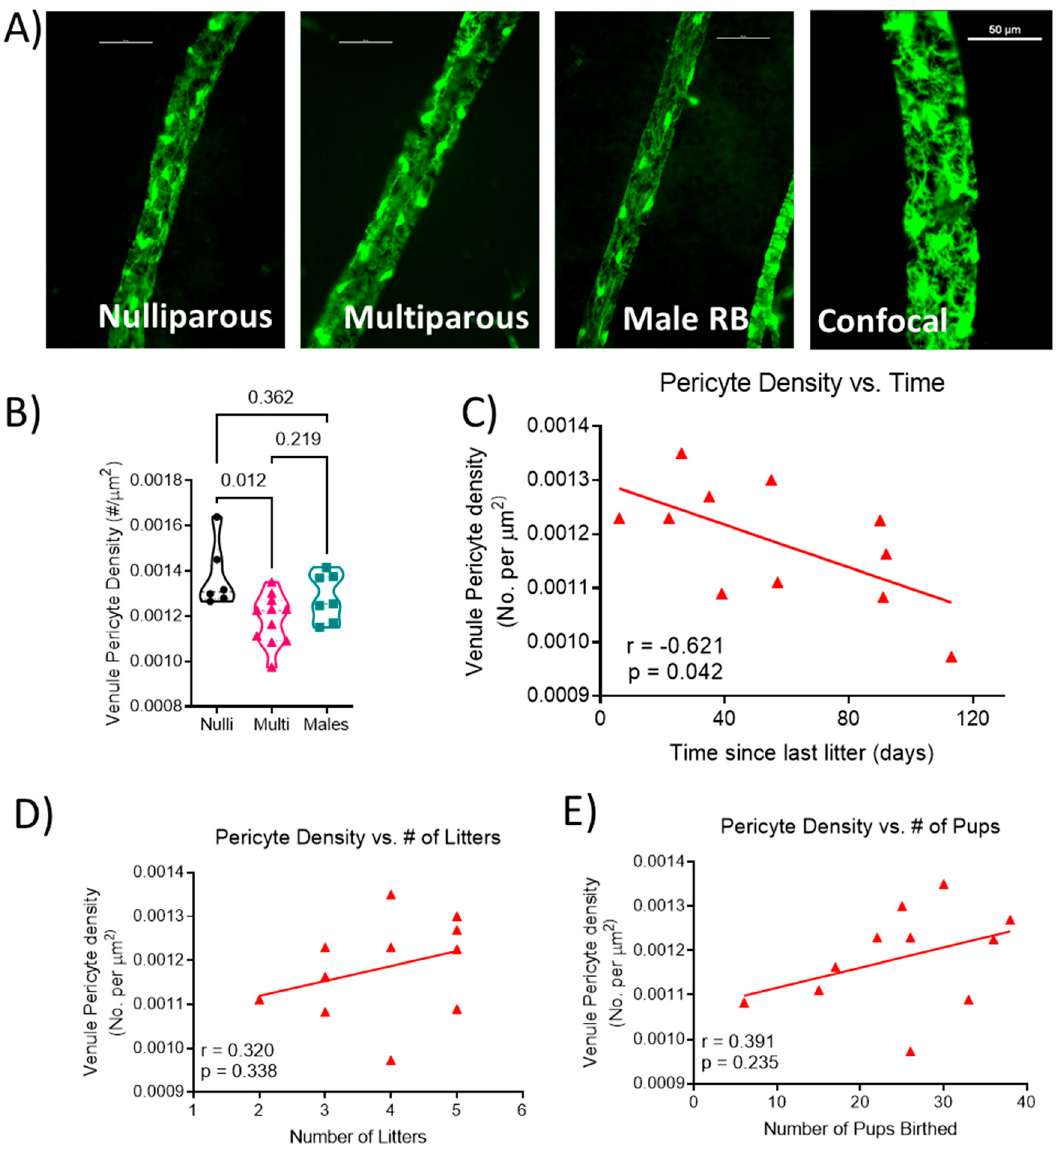
Figure 2. Quantification of venule coverage by pericytes. ( A ) Representative images from each group showing venule segments covered by pericytes. Unlabeled vessel segment represents a maximum projection image of z-stack obtained via confocal microscopy. Scale bar represents 50 µm. ( B ) pericyte density (number of pericytes per area of venule), relationship between ( C ) time since the last delivery, ( D ) number of litters, ( E ) number of pups birthed and venule pericyte density. Each data point represents the mean density of pericytes from a segment of each venule present in the retina per mouse. Thick dashed line represents the median. n = 6–11 mice per group. Pericyte density data were analyzed using one-way ANOVA followed by Tukey’s post-hoc test. Correlations were calculated using Pearson r correlation.